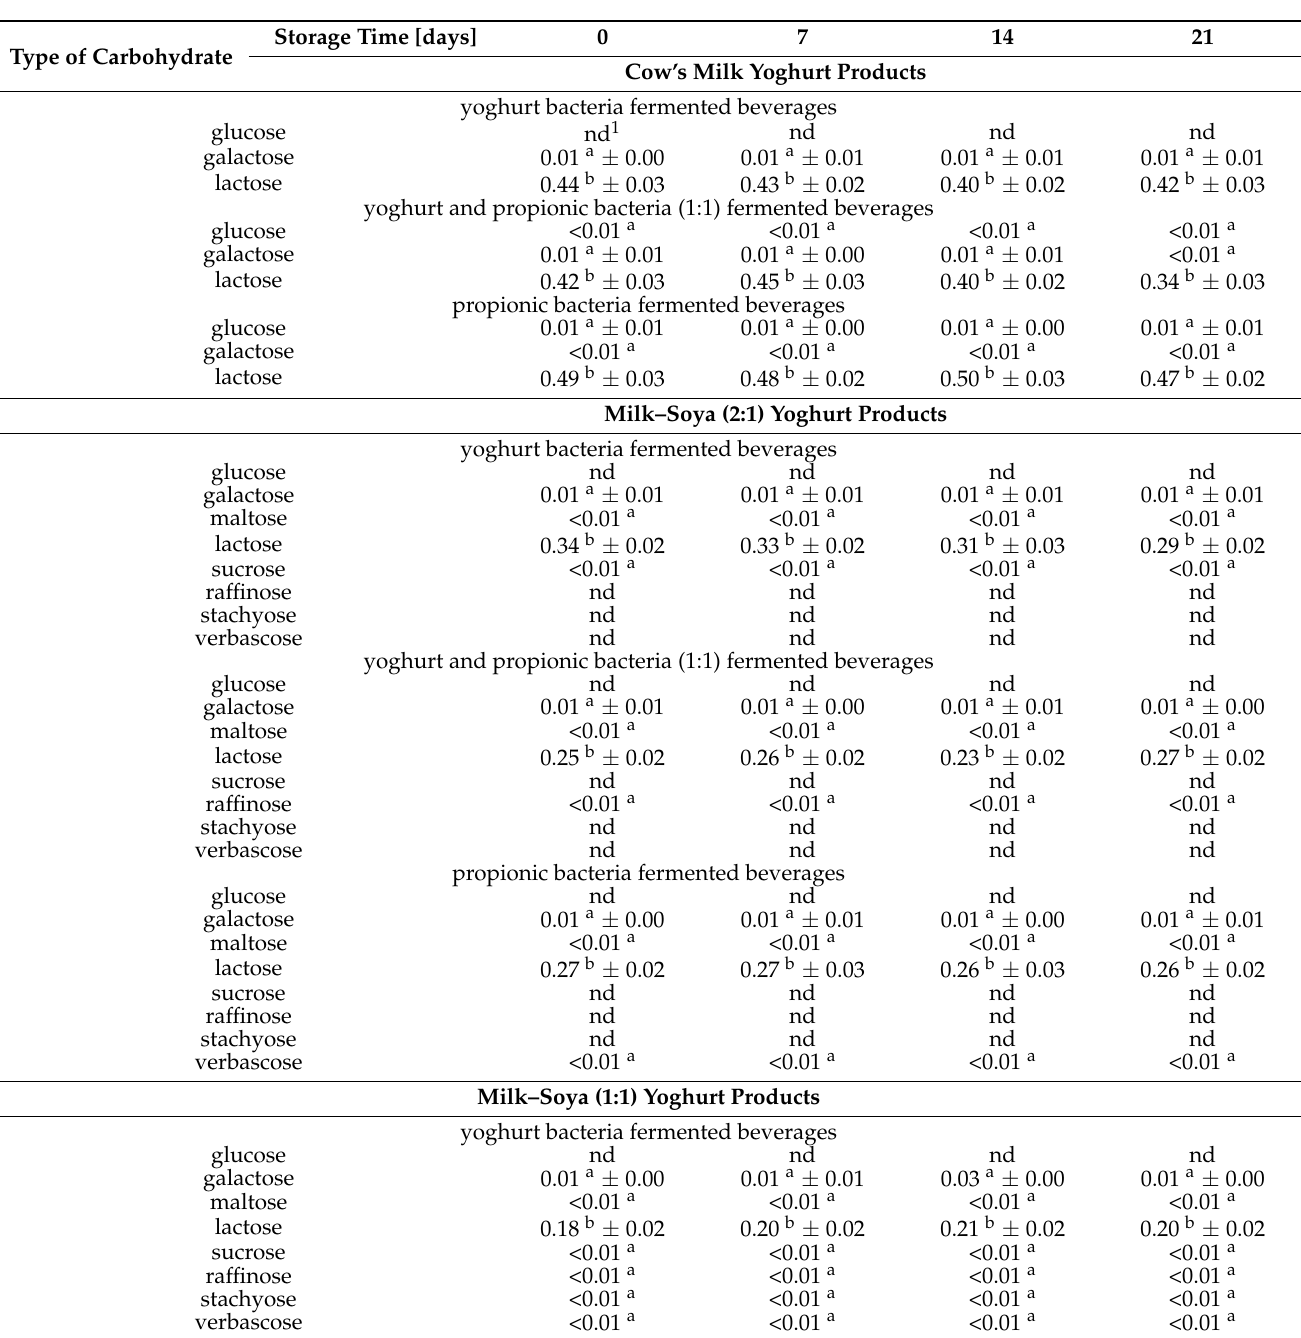
Table 4. Selected carbohydrate contents (g/100 g) in milk, milk–soya, and soya yoghurt products obtained from beverages fermented using different starter cultures and stored at 5 ◦ C for 21 days (mean values and standard